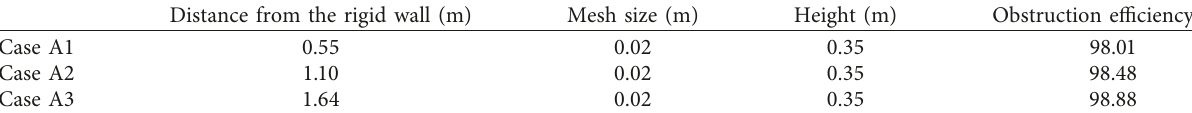
Table 2: Obstruction efficiency of RNB at different positions.